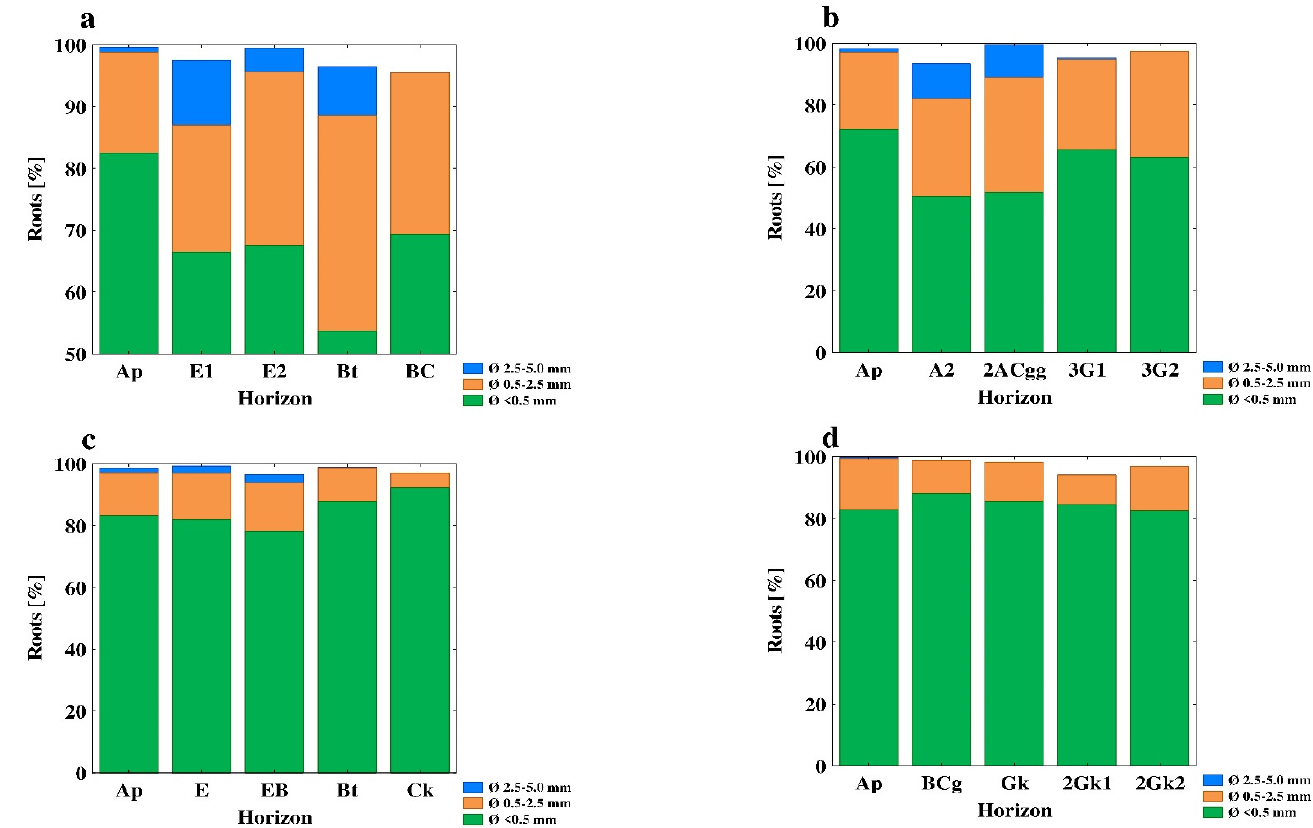
Figure 6. Contribution of different root diameters (mm) in the total length of the root system; winter wheat profiles ( a , b ) and lucerne profiles ( c , d ).